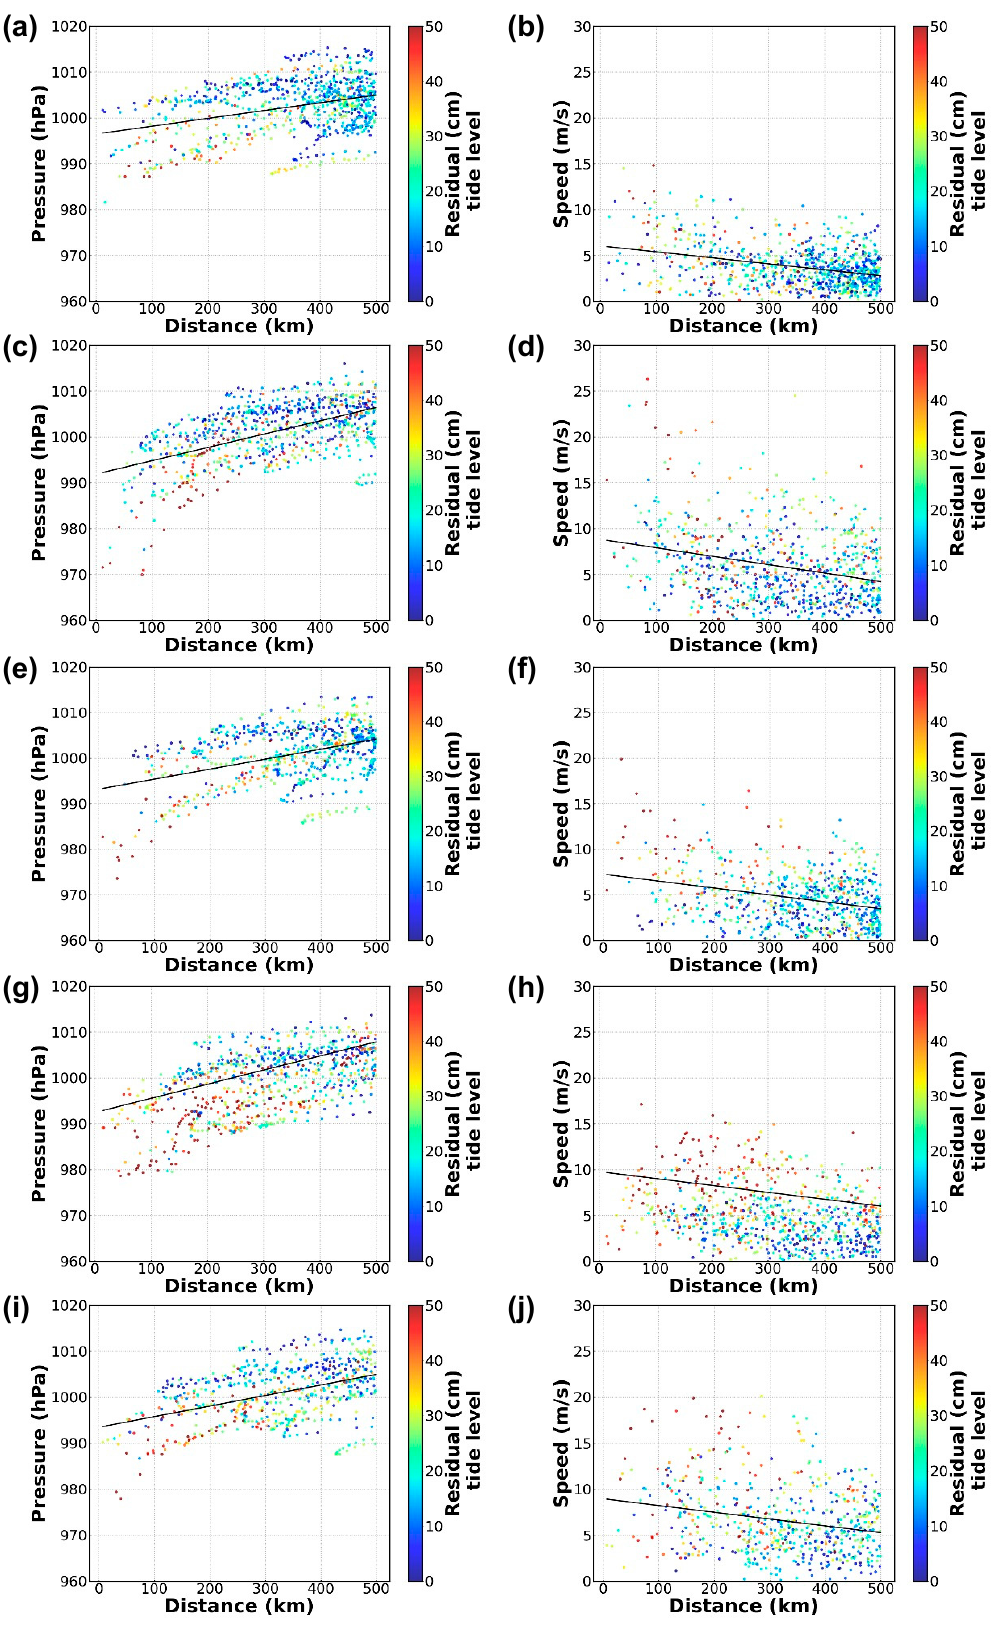
Figure 5. Correlations between air pressure ( left column ) and wind speed ( right column ) and distance from typhoon center from the observational data at ( a , b ) Busan, ( c , d ) Geomundo, ( e , f ) Tongyeong, ( g , h ) Wando, and ( i , j ) Yeosu during typhoons in 2010 to 2019.